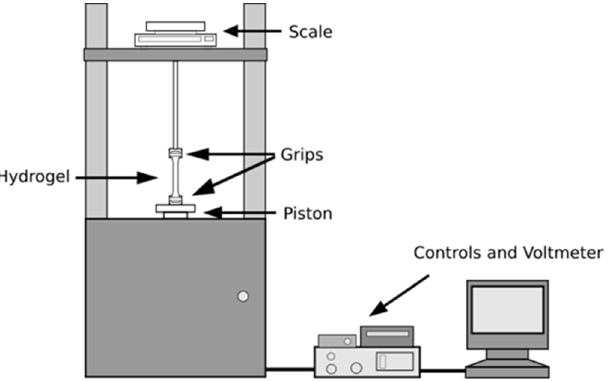
Figure 3. Schematic diagram of the apparatus for measurements of tensile strength.